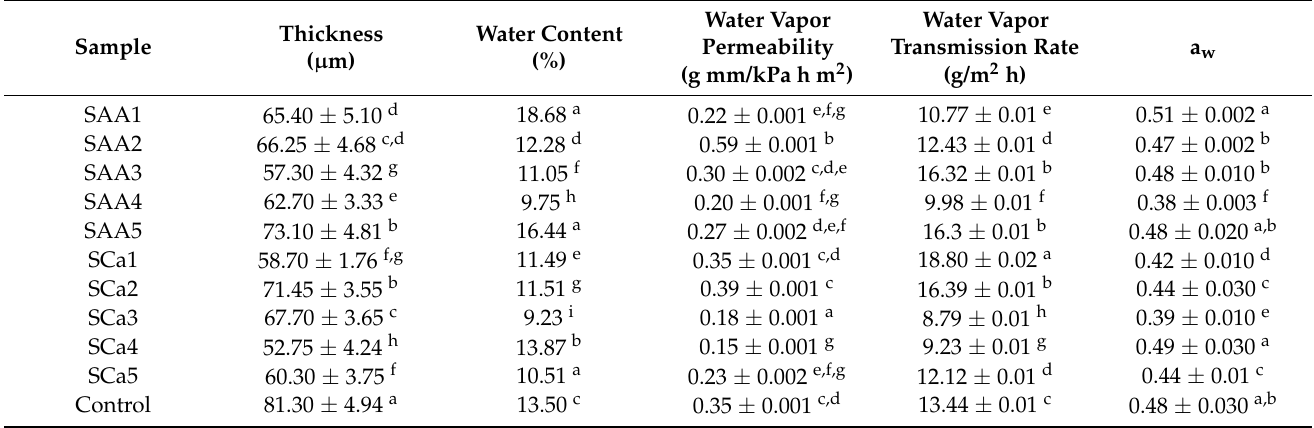
Table 1. Barrier properties of membranes with a fixed mixture of alginate and agar and added with an increasing amount of AA and CaCl 2